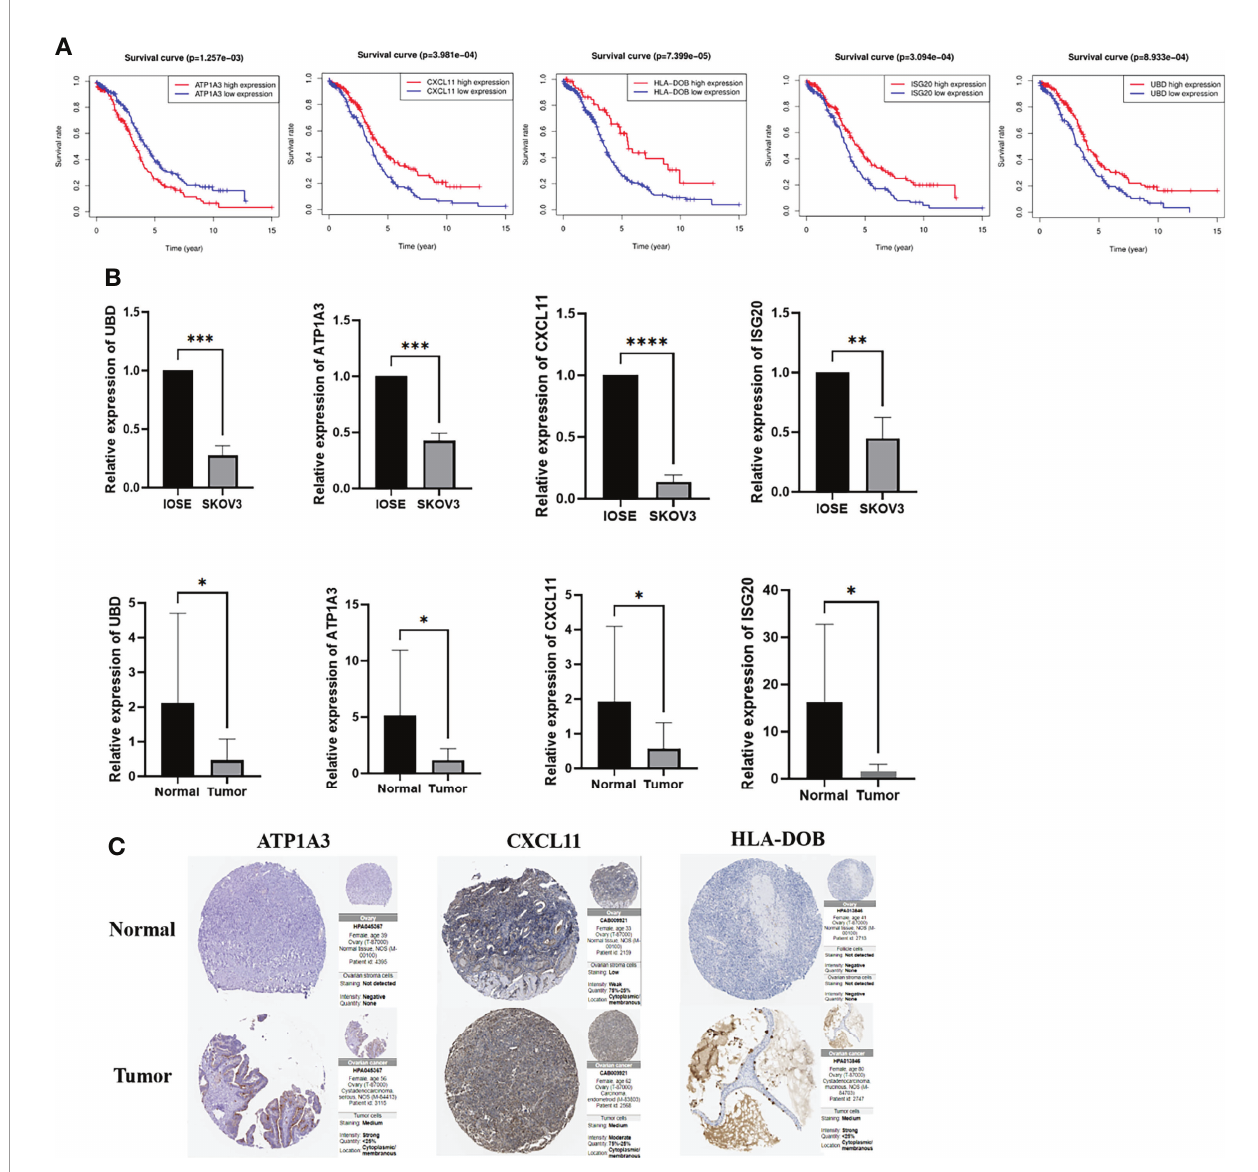
FIGURE 10 | Survival analyses and the mRNA expression level of the key genes in the clinical samples and cells. (A) Kaplan – Meier curves for comparison of the OS between low- and high-expression groups (B) Comparison of the mRNA expression of the key genes in the clinical samples and cells (C) Comparison of the protein expression of the key genes in the Human Protein Atlas. * P < 0.05, ** P < 0.01, *** P < 0.001 and **** P <